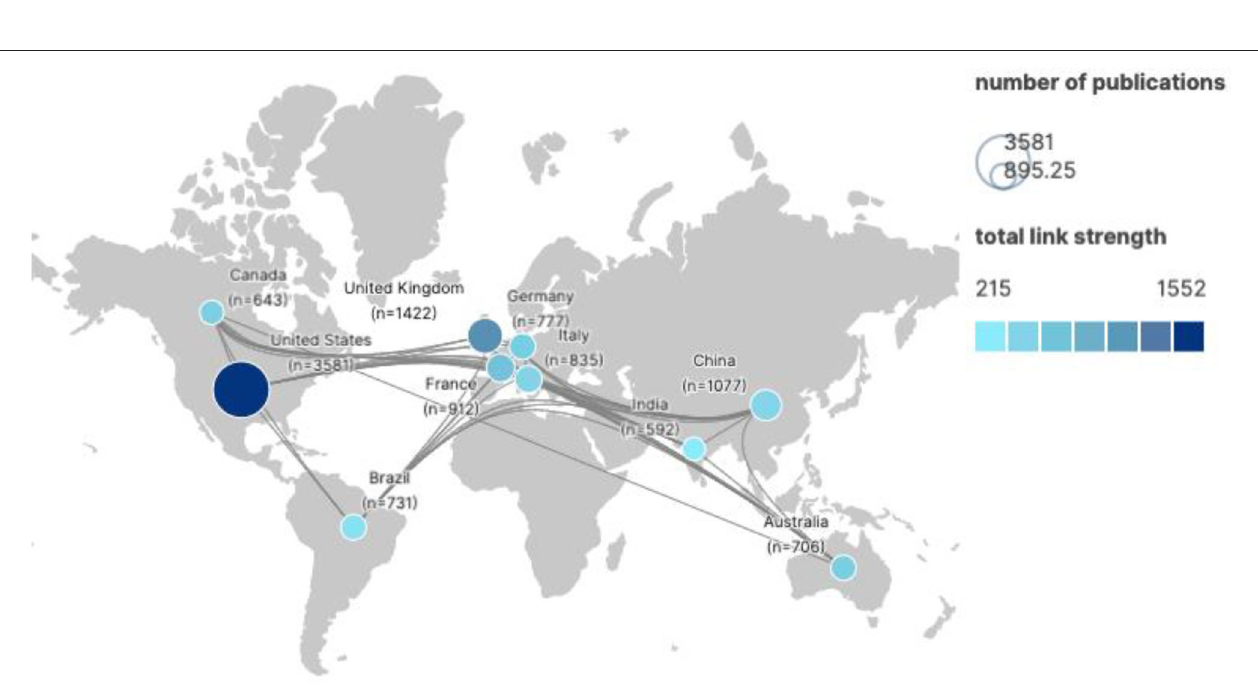
FIGURE 3 | Top 10 national collaborative networks for the four priority topics of One Health, 2003–2021.